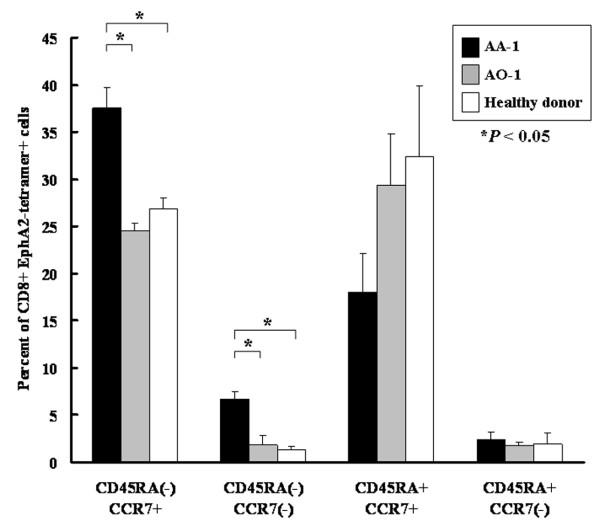
A majority of EphA2883–891-reactive CD8+ cells in AA-1-derived PBMC are central memory cells. Freshly thawed PBMCs were stained with anti-CD8 mAb, EphA2883–891-tetramer, anti-CD45RA mAb, and anti-CCR7 mAb and analyzed as described in Materials and Methods. Black, gray and white columns indicate the percentage of each population in EphA2883–891-specific CD8+ cells derived from AA-1, AO-1, and healthy donor, respectively. Bars indicate standard errors. Higher percentages of central memory T cells (CD45RA-/CCR7+) and effector memory T cells (CD45RA-/CCR7-) were observed in EphA2-tetramer+/CD8+ T cells of AA-1 compared to those of AO-1 and the healthy donor (P < 0.05; ANOVA).